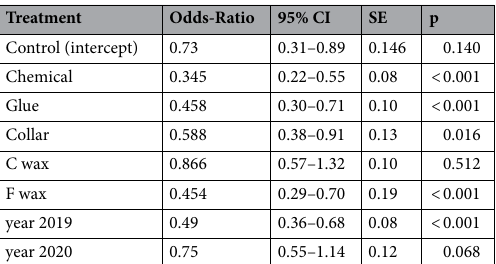
3 years of the experiment as affected by treatments at the clear-cut site. Treatment Odds-Ratio 95%